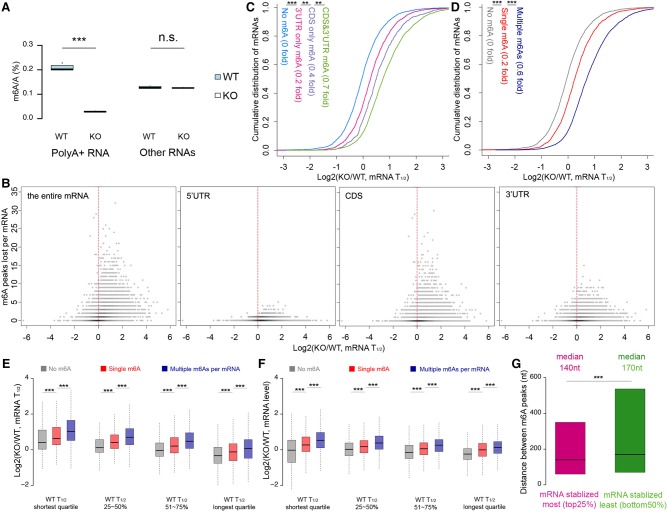
Data analysis of mouse ESC m6A residues in mRNA. (A) Global reduction of m6A after Mettl3 knockout. (***) P < 10−5; (n.s.) not significant, two-sample t-test. (B) Scatter density plot of the number of m6A peaks lost per mRNA versus mRNA T1/2 changes. “m6A peaks lost” refers to m6A peaks that were detected in wild-type mRNA but not in knockout mRNA (red dots in Supplemental Fig. 11). (C) Cumulative distribution plot of mRNAs versus mRNA T1/2 changes upon global m6A loss, grouped by the different regions of mRNA where m6A loss occurred. (**) P < 10−10; (***) P < 10−100, Kolmogorov-Smirnov test. (D) Cumulative distribution plot of mRNA versus mRNA T1/2 changes upon global m6A loss, grouped by the number of m6A peak loss per mRNA. (***) P < 10−40, Kolmogorov-Smirnov test. (E) The effect of m6A loss on mRNA T1/2 changes in different m6A content and different T1/2s in mouse ESCs. (Gray) No m6A per mRNA; (red) single m6A per mRNA; (blue) multiple m6As per mRNA. (***) P < 10−5; Wilcox ranked test. (F) Same mRNAs as in E but comparison is of steady-state mRNA levels from groups with different T1/2s. (***) P < 10−5, Wilcox ranked test. (G) m6As on mRNAs with T1/2s increased most upon global m6A loss tend to be clustered. The largest T1/2 effect upon global m6A loss is labeled in pink, and the average and least T1/2 effect are labeled in green. (***) P < 10−15; Wilcox ranked test. We observed the same result even when matching the m6A numbers in both groups of mRNAs.